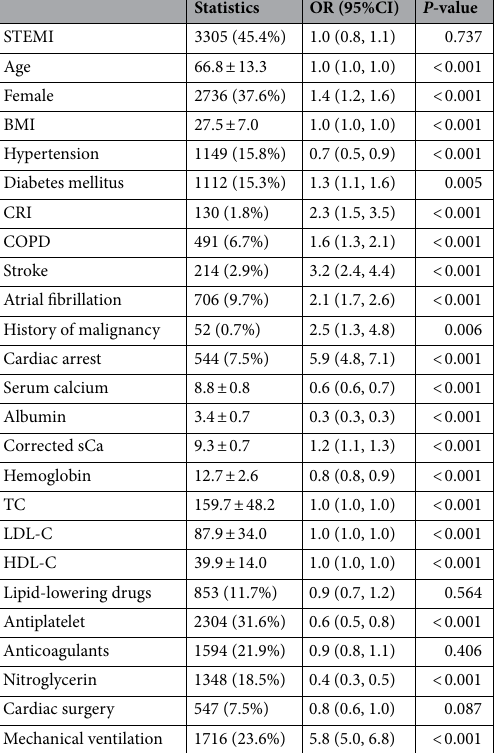
Table 2. Univariate analysis. STEMI, ST-segment elevation myocardial infarction; BMI, body mass index; CRI, chronic renal insufficiency; COPD, chronic obstructive pulmonary disease; Corrected sCa, corrected serum calcium; TC, total cholesterol; LDL-C, low-density lipoprotein cholesterol; HDL-C, high-density lipoprotein cholesterol.